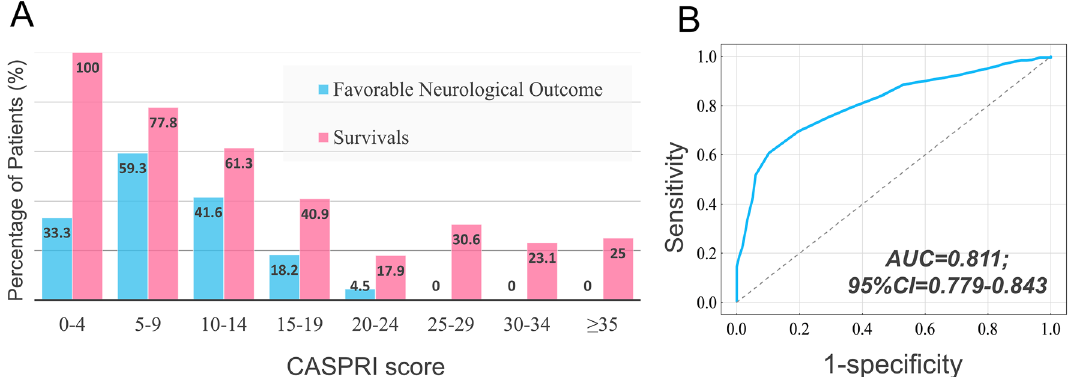
Figure 2. Predictive performance of the CASPRI score. ( A ) Graphical visualization of the corresponding percentage of cardiac arrest patients who received TTM in current cohort who survived to hospital discharge and who had favorable neurological outcomes for every 5-points increases of CASPRI score. ( B ) ROC curve with indicated AUC of the CASPRI score univariable logistic regression model to predict favorable neurological outcomes in cardiac arrest patients who received TTM. AUC area under the curve, ROC receiver operating characteristic, CASPRI Cardiac Arrest Survival Post-resuscitation In-hospital, TTM targeted temperature